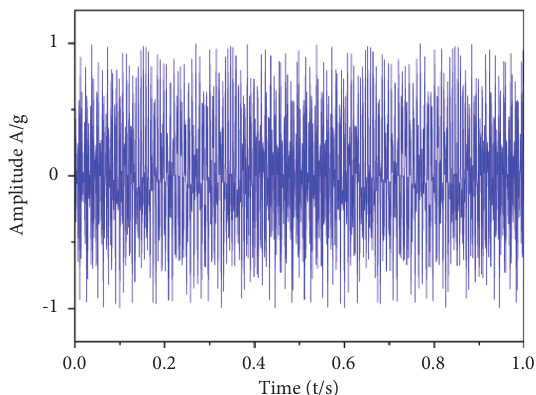
Figure 4: The time-domain waveform without noise of the analog signal.